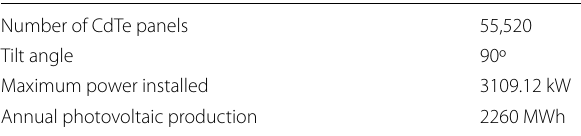
Table 12 Data for cadmium telluride photovoltaic system sizing for Pico Number of CdTe